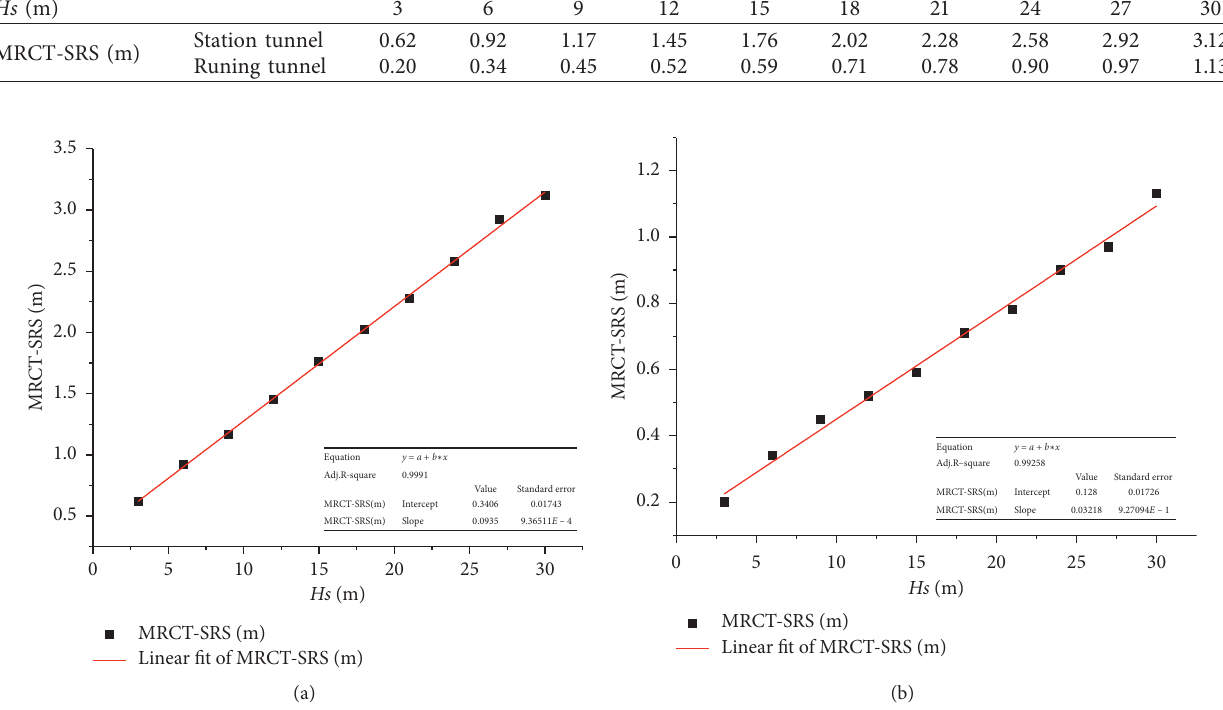
Figure 6: Metro tunnel MRCT-SRSs change with respect to Hs. (a) Station tunnel. (b) Running tunnel.